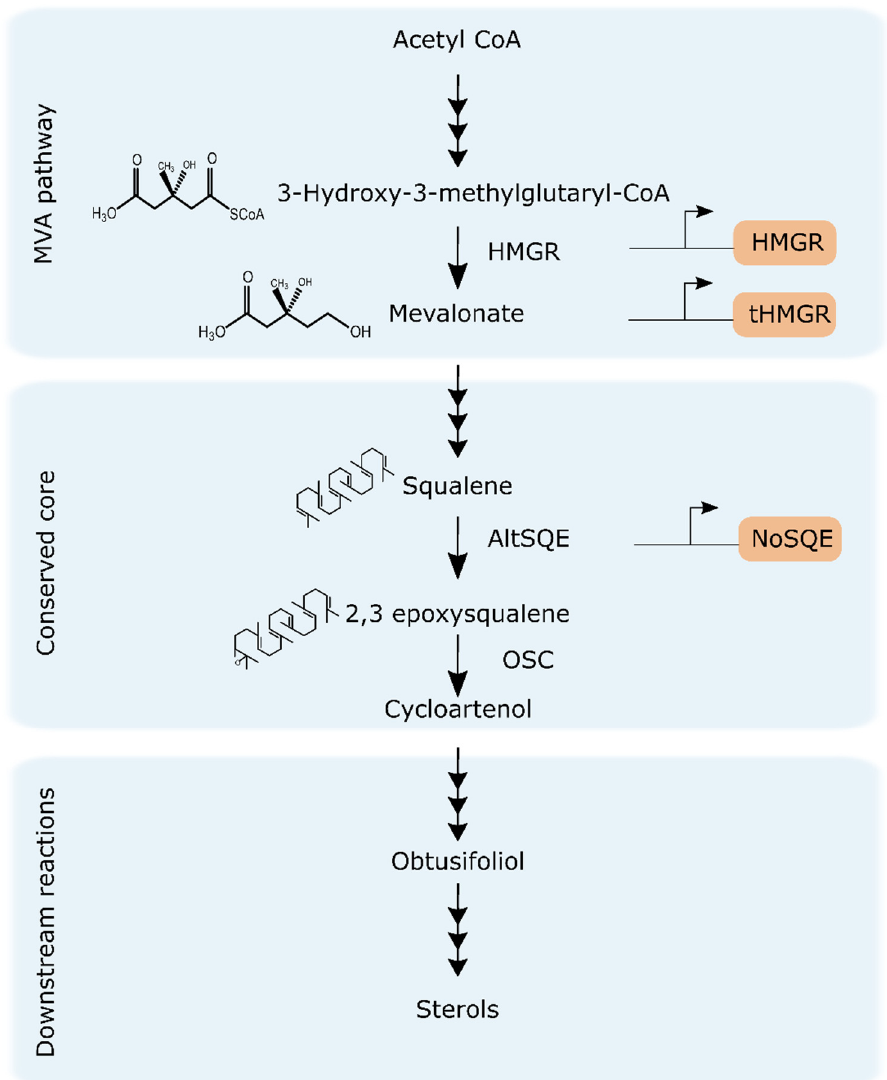
Figure 1. Upstream reactions and conserved core of sterol biosynthesis pathway in diatoms and genetic targets overexpressed in this study, highlighted in orange. Mevalonate pathway, MVA; 3-hydroxy-3-methylglutaryl-coenzyme A reductase, HMGR; truncated HMGR, tHMGR; alternative squalene epoxidase, AltSQE; squalene epoxidase from N. oceanica , NoSQE; oxidosqualene cyclase, OSC.